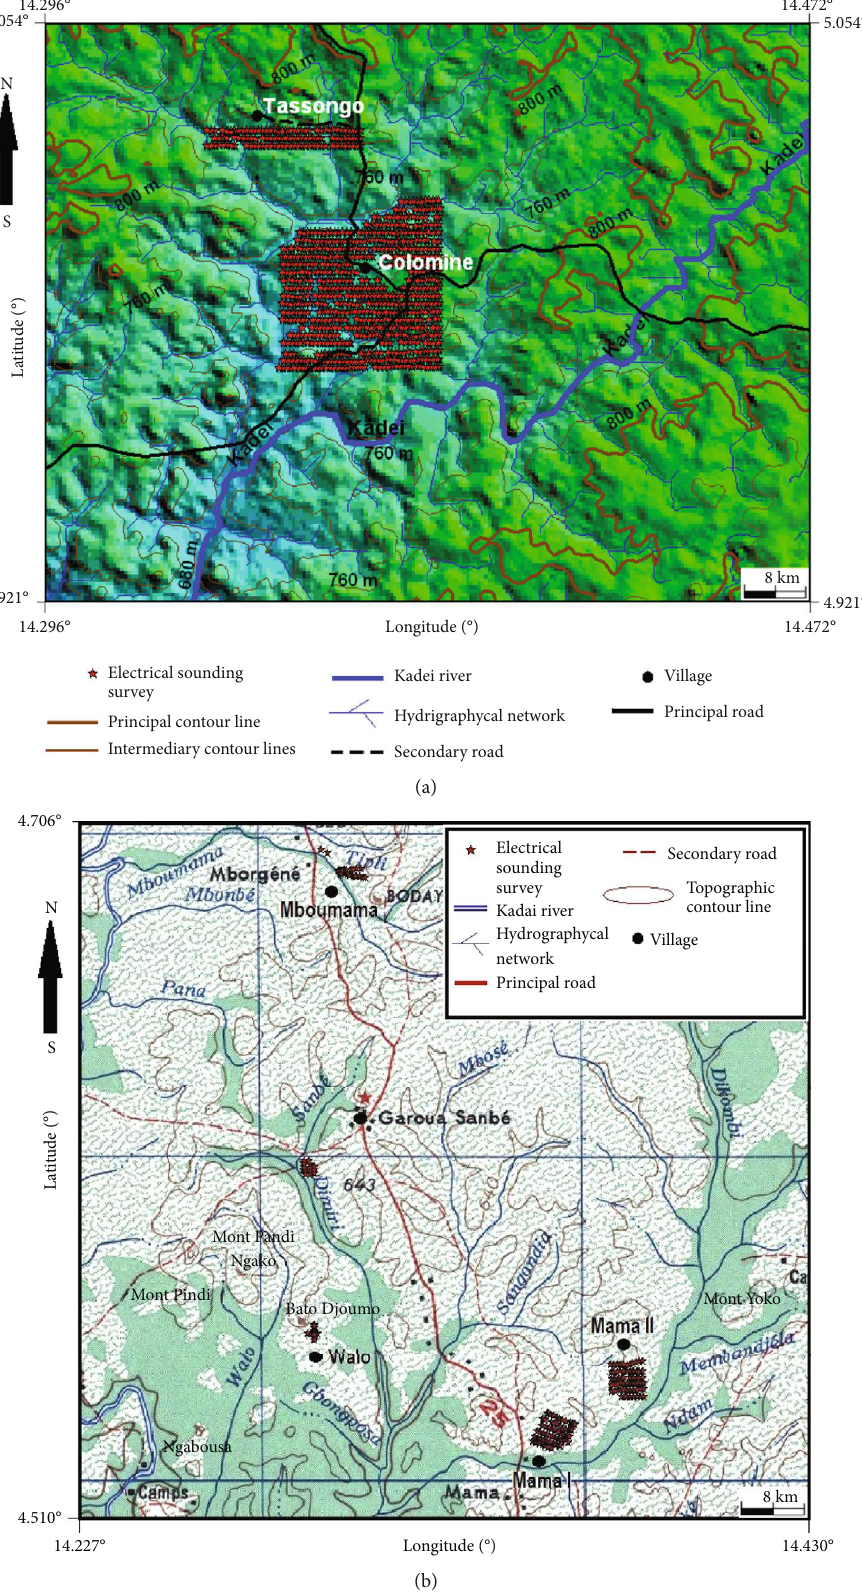
Figure 1: (a) Localization map of electrical soundings and study area (area 1). (b) Localization maps of electrical soundings and study area (area